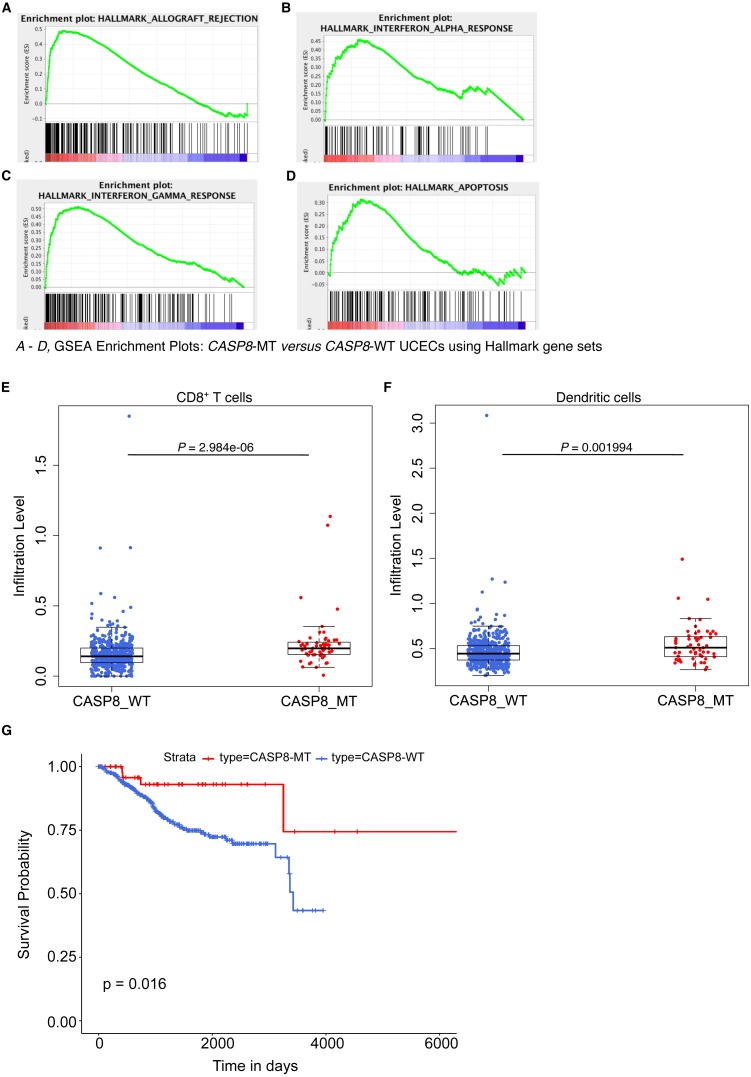
CASP8-MT UCECs display an immune gene signature, have higher numbers of certain types of infiltrating immune cells, and survive better than CASP8-WT UCECs.(A–D) GSEA was performed using a pre-ranked list generated using log2FC values from the edgeR analysis. Some GSEA Hallmark gene sets enriched in CASP8-MT UCECs (A–D) are shown. (E, F) Immune cell infiltration levels in CASP8-WT (blue-filled circles) and CASP8-MT (red-filled circles) UCECs were compared using the immune cell infiltration data available at TIMER. Boxplots showing the levels of CD8+ T cells and dendritic cells in the two UCEC groups are displayed. Significance testing was performed using the unpaired two-sided Wilcoxon test. All comparisons with P-value < 0.005 were considered significant and are indicated in the plots. (G) Kaplan-Meier plots showing the survival probability of patients with CASP8-WT or CASP8- MT UCEC tumors. Log-rank test was used to compare the two curves and the log-rank P-value is indicated.